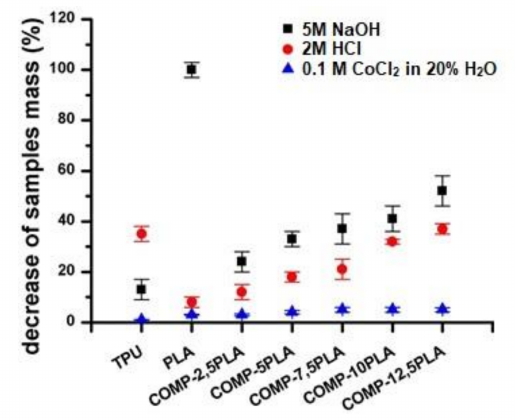
Figure 6. Decrease of samples mass after 15 days of degradation in selected media (0.1 M CoCl 2 in 20% H 2 O 2 , 2 M HCl and 5 M